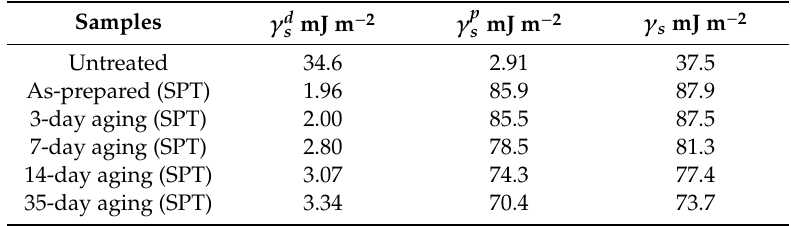
Table 1. Summary of the contributions of the γ sp and γ sp components to γ s at various aging times.